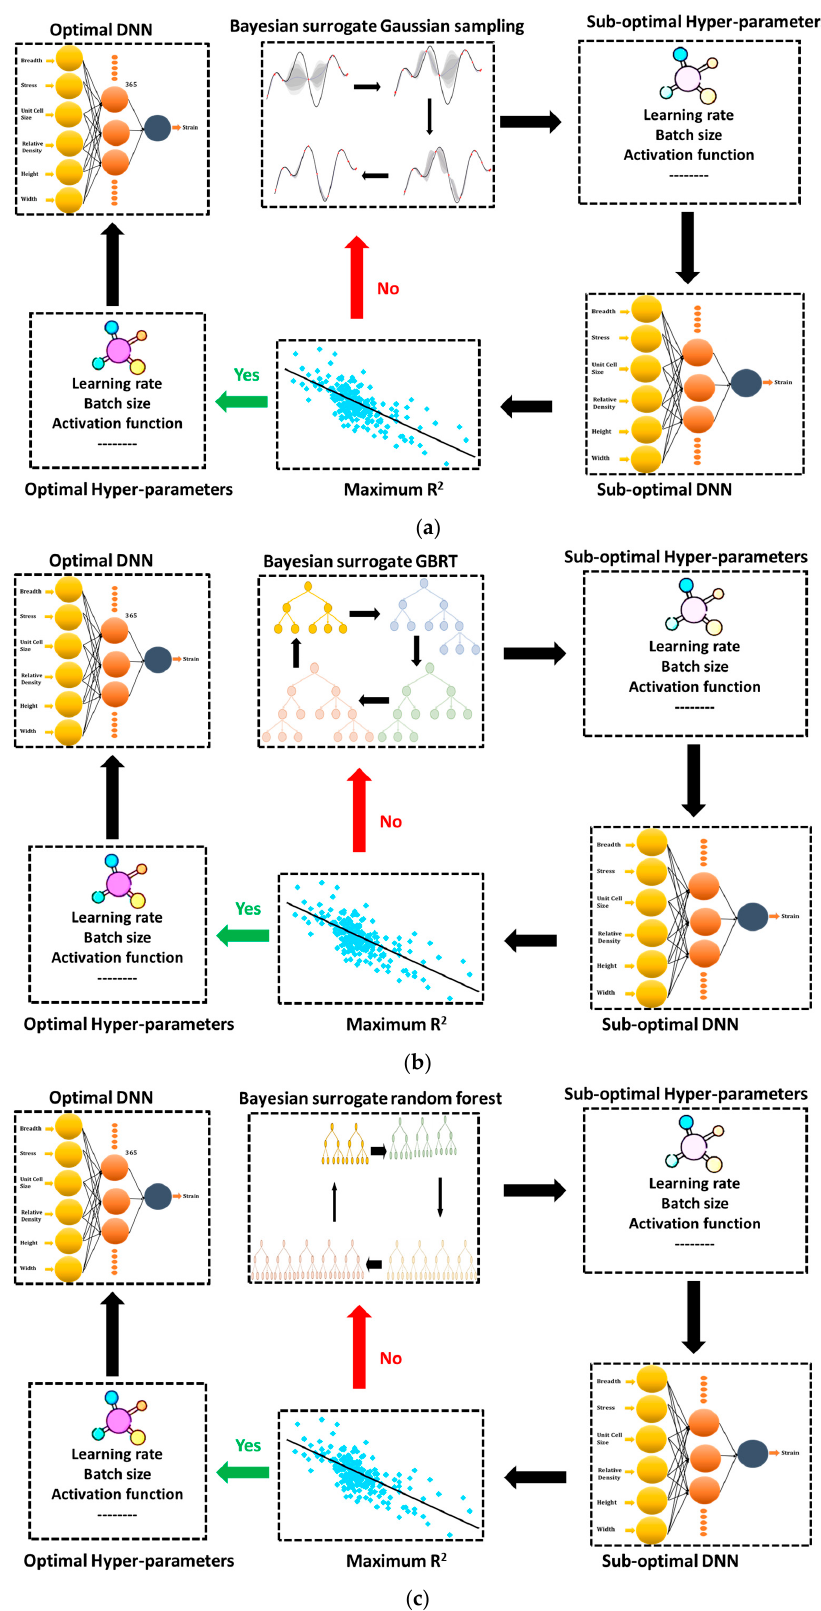
Figure 2. Flow chart of the ( a ) GPR, ( b ) GBRT, and ( c ) RF hyper-parameters optimization schemes. Gradient boosting, similar to the decision tree, is an aggregation approach that inte- grates several learning algorithms. A GBRT addressing prediction applications is a mix of gradient boosting and regression trees which employs groups of regression trees to mini- mize error across a huge single structure, as even the names suggest. The error values created by subtracting the estimated value from the intended target truth value in the first tree are given to the second successive tree. The error values obtained from subtracting the summation of the values obtained in the first and second trees from the primary target truth value are used to build the third tree. This procedure is continued till the parameters reach their maximum value. The final projected value is calculated by adding all the pre- dicted values from decision trees. The RF algorithm is a collection of binary trees based on two stochastic variables: a randomly generated bootstrap set and a randomly selected set of features for every node. The bootstrap set, which comprises the samples for creating a tree, and the out-of-bag